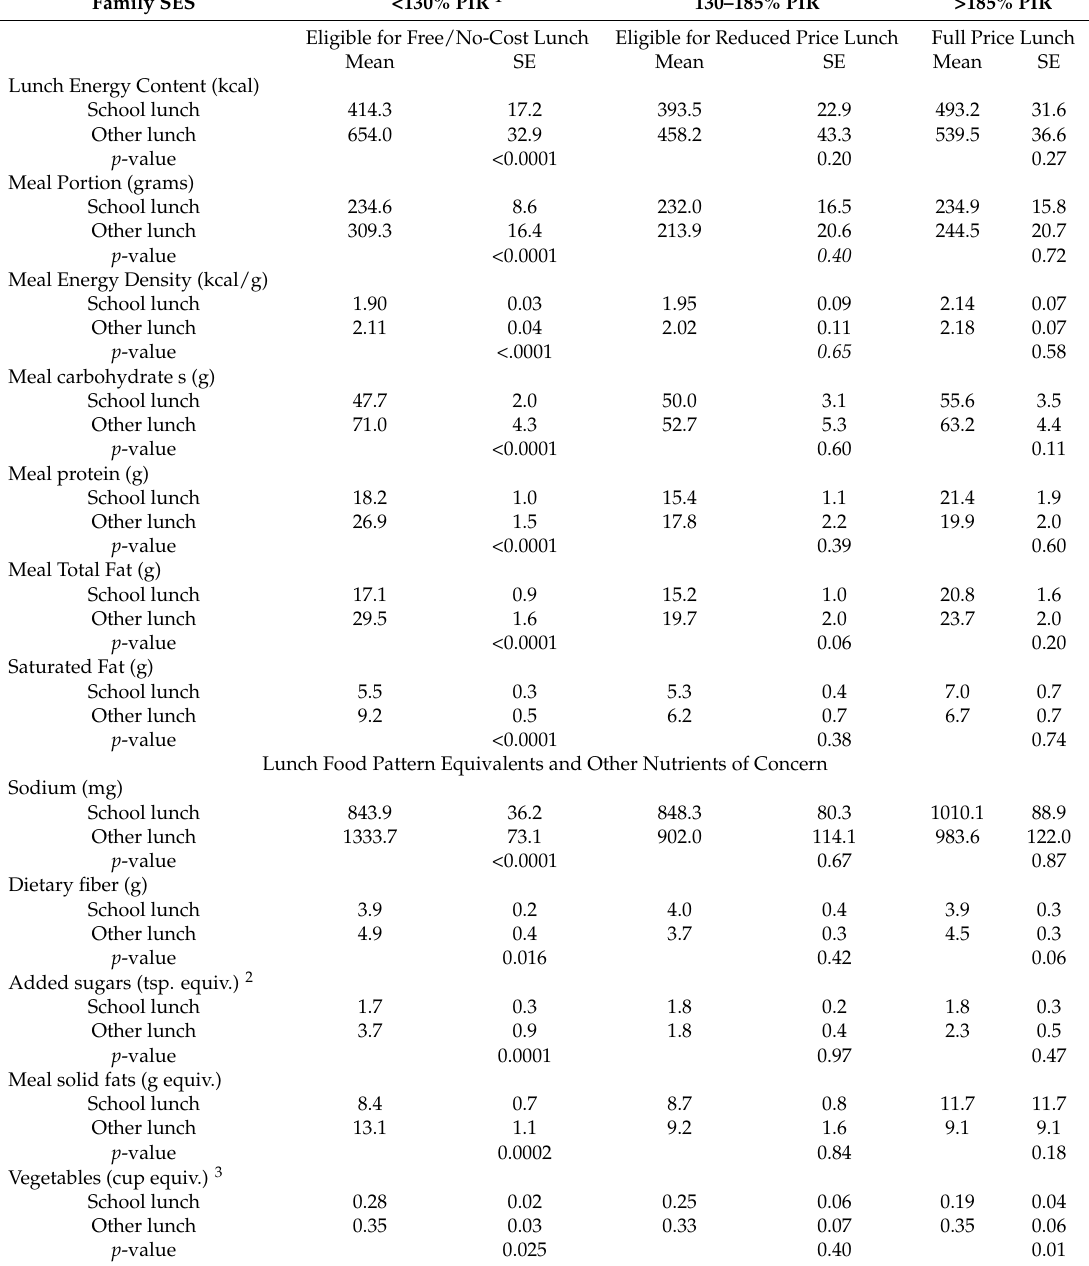
Table 3. Nutritional Intake of Students Consuming School-Provided Lunch (SL) vs. Lunch Obtained Elsewhere (Non-SL) by Socioeconomic Status